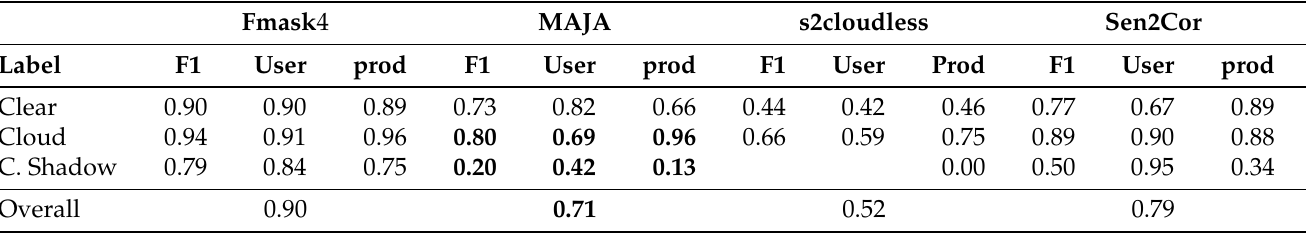
Figure 1. Updated Figure 3d [1]. Clouds detected on the Sentinel–2A image T19LFK of 7 May 2018. The color picture ( a ) uses bands 4, 3, and 2; ( b ) MAJA cloud mask. Table 3. Updated version of Table 5 [1] with updated values of MAJA (in bold face). User and producer accuracies for each tile and cloud-detection algorithm.